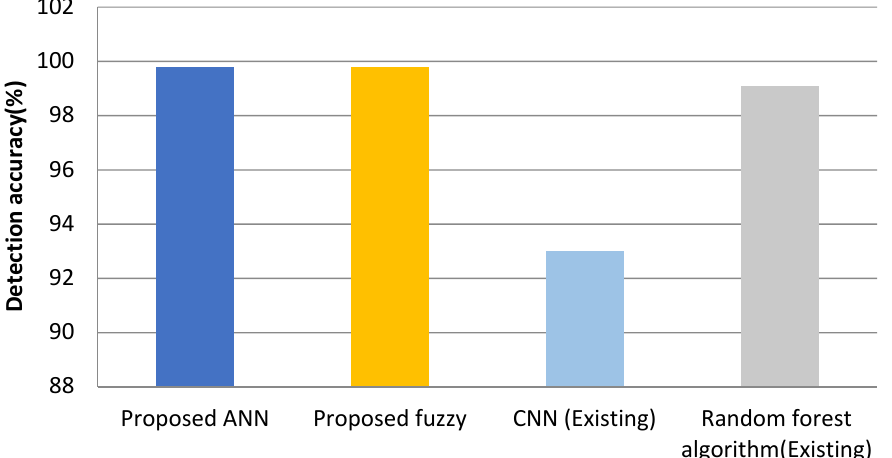
Figure 7. Comparison of the detection accuracies of proposed and existing mechanisms. Table 3. Detection accuracy of two proposed mechanisms.